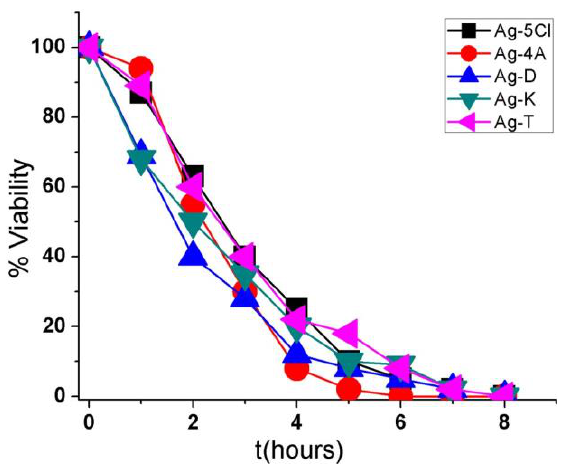
Figure 4. Viability (percentage of CFU/mL) as a function of time (hours) for the five compounds against the bacterium Staphylococcus epidermidis.